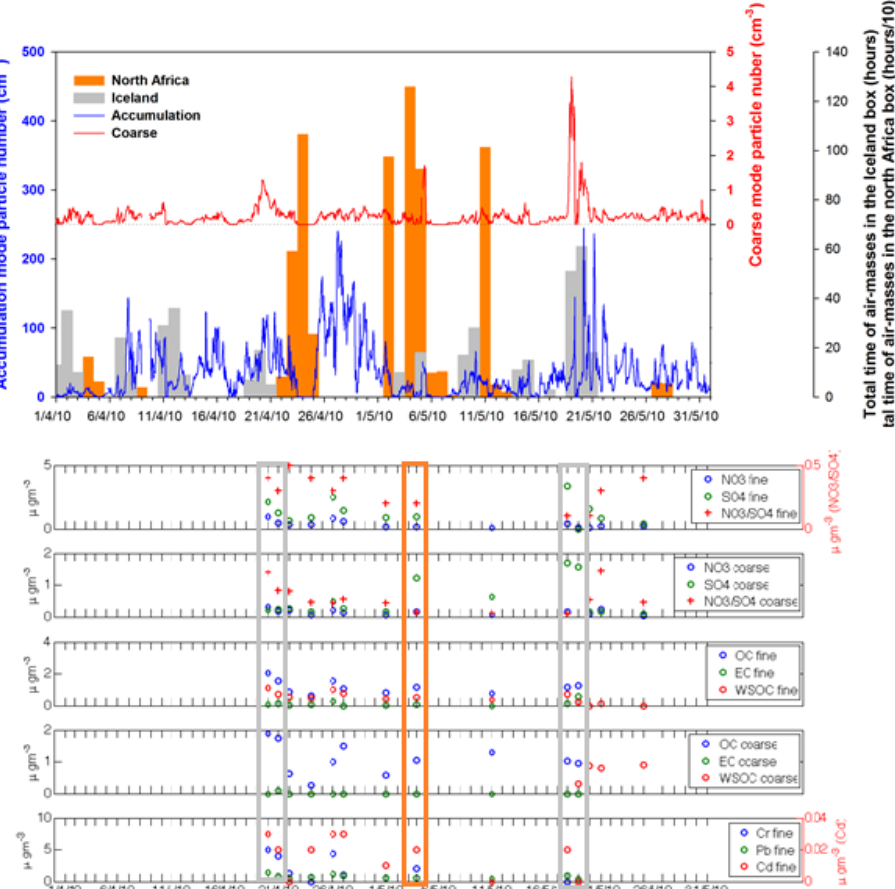
Fig. 1. (a) Particle number concentration recorded at CMN from 1 April to 31 May 2010 measured by OPC (0.3–20µm), separately for the accumulation mode (<1µm) and coarse mode (>1µm). The vertical bars denote the daily total number of back-trajectory points falling within the “Iceland” (grey) and the north Africa (orange) geographical boxes. (b) Temporal evolution of sulphate, nitrate, NO 3 /SO 4 ratio, OC, EC and WSOC, separately for the fine and coarse mode, and Cr, Pb and Cd in the fine fraction.